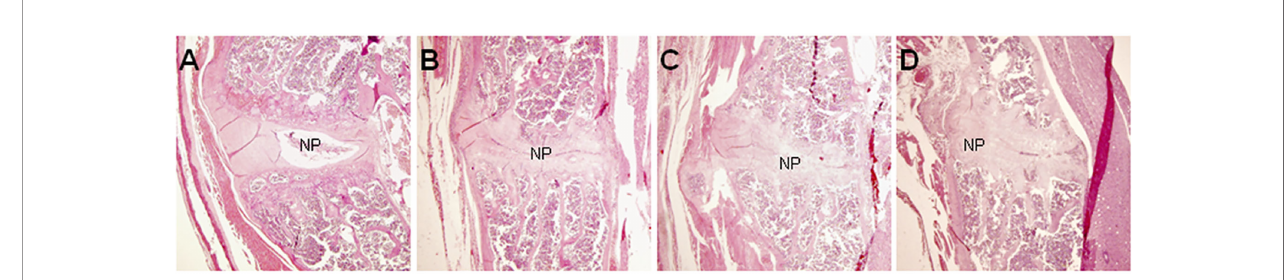
FIGURE 1 | Pathological changes of spondylitis in BALB/c mice induced by PGA injections (HE, × 40). At the center of each fi gure is the IVD. (A) HC mouse; (B) Extensive narrowing of intervertebral space in a PGISp mouse; (C) More extensive narrowing of intervertebral space; (D) Bridging bone formation in part of the intervertebral space; NP= nucleus pulposus.